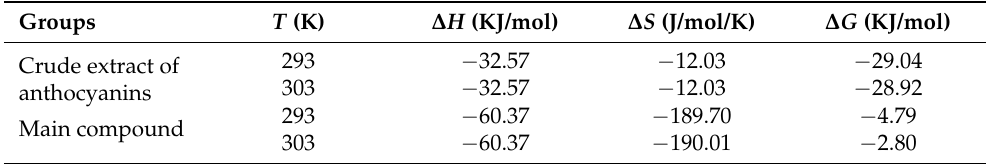
Table 5. Thermodynamic analysis of anthocyanins from the fruit of L. ruthenicum on pancreatic lipase at different